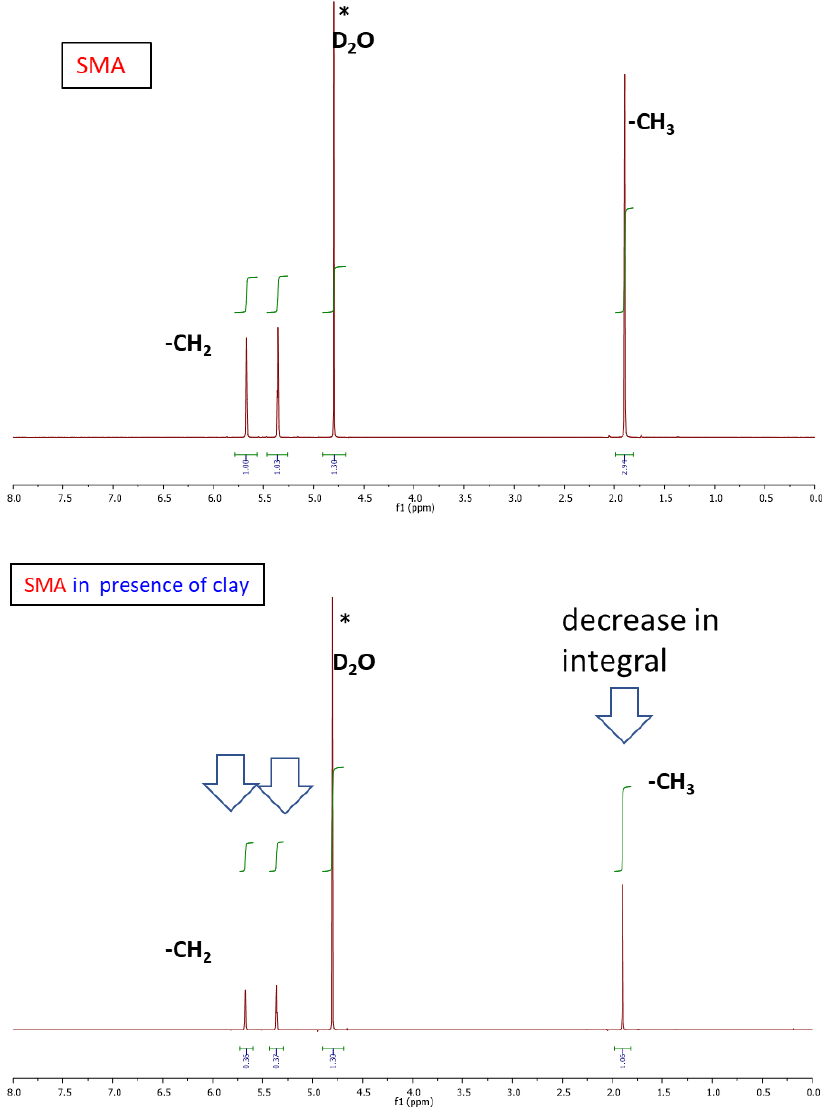
Figure 2. Proof of SMA adsorption on the RDS clay via 1 H-NMR spectroscopy, using the D2O solvent as reference signal (marked with *) and exploiting the fact that the protons of adsorbed SMA relax slowly and hence ‘spectroscopically disappear’: Only the signals of free SMA are visible.